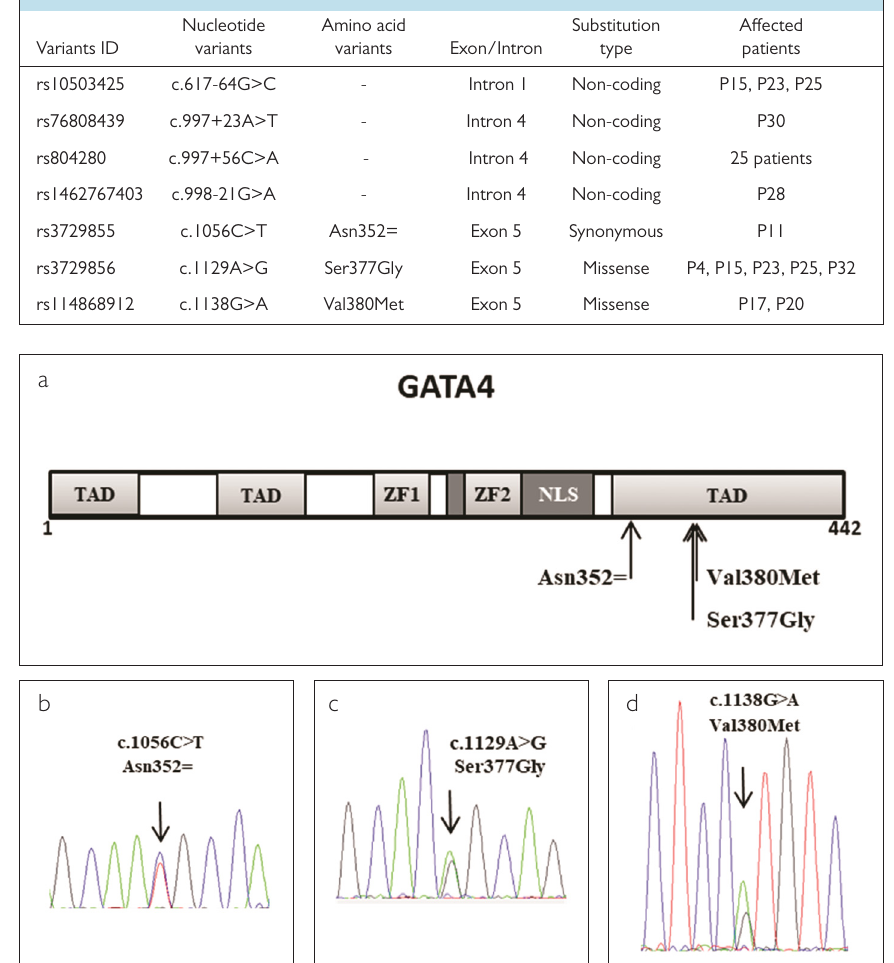
Figure 1 a-d. (a) GATA4 domains with sites of exonic variants and (b-d) Sequencing chromatograms of detected GATA4